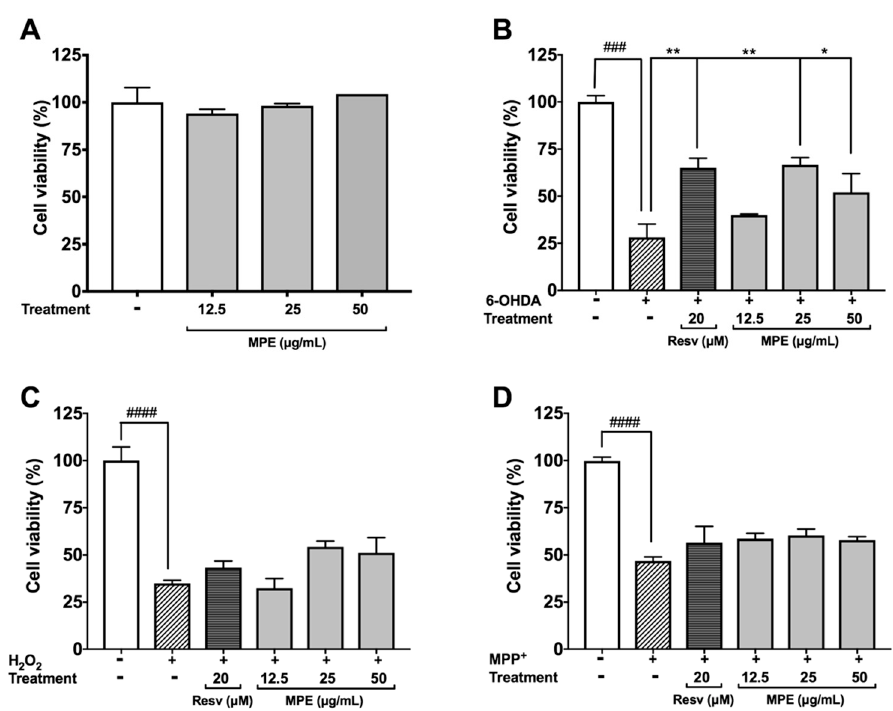
Figure 3. Effects of MPE (12.5, 25, and 50 μ g/mL) on cellular viability of SH-SY5Y human neuroblastoma cells against toxic models of Parkinson’s disease. Effects of MPE (12.5, 25, and 50 µ g/mL) alone on SH-SY5Y cell viability ( A ), of MPE after 6-OHDA-induced toxicity ( B ), of MPE against H 2 O 2 -induced toxicity ( C ), and of MPE against MPP + induced toxicity ( D ). Data shown as mean ± standard error ( n = 3), significance was reported by ANOVA and subsequent Dunnett multiple as compared with control p ≤ 0.001 (###), and p ≤ 0.0001 (####); as compared with toxic agent, p ≤ 0.05 (*), and p ≤ 0.01 (**).